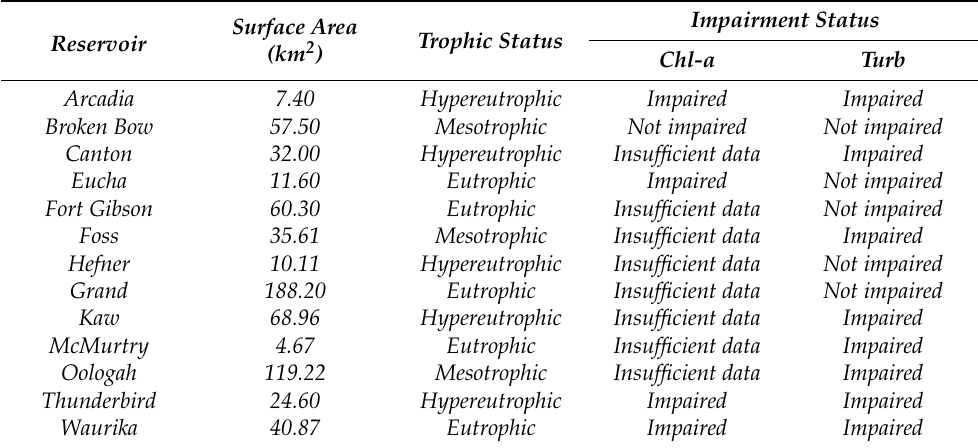
Table 2. Characteristics of the reservoirs used in this study. This information was obtained from the Oklahoma Water Resource Board’s website